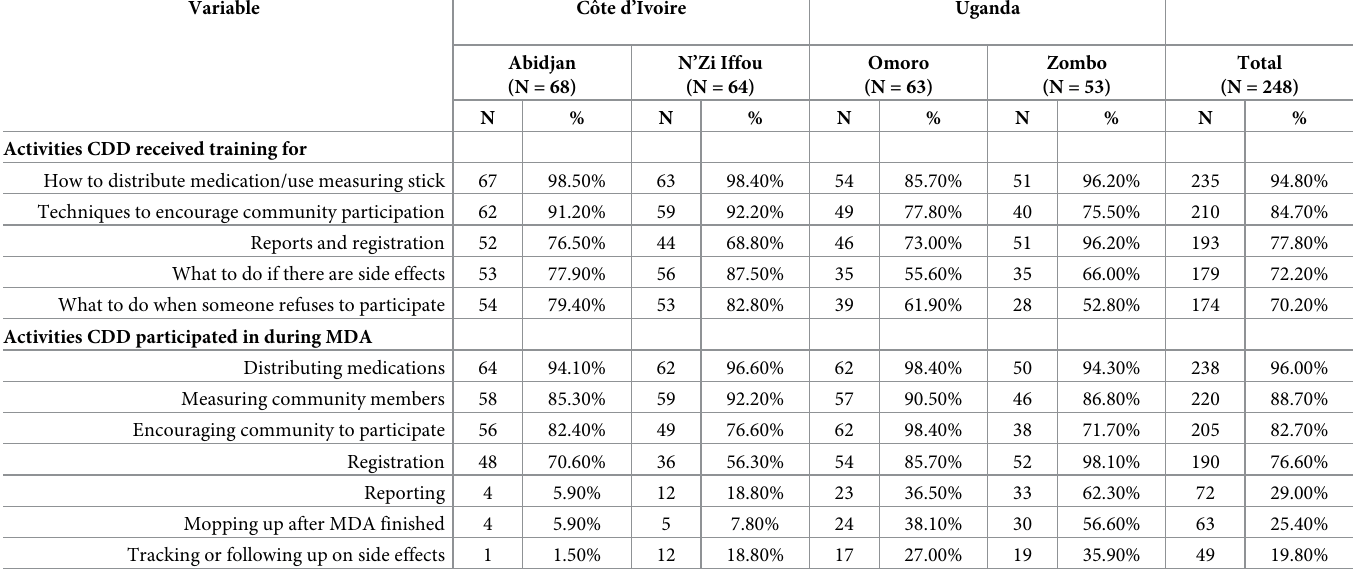
Table 4. CDD training and activities carried out during MDA, by